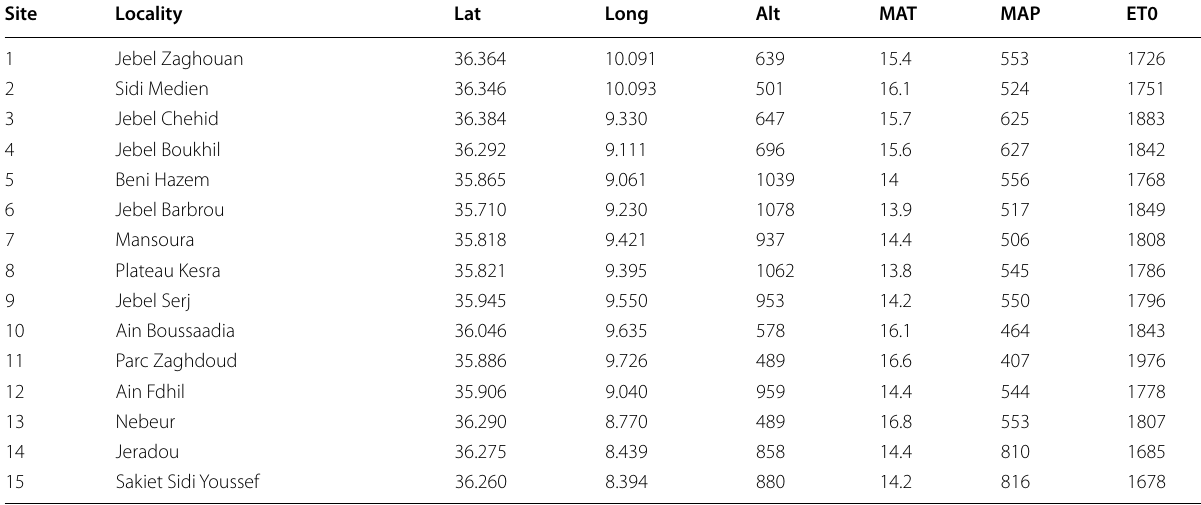
Table 1 Locations of the 15 source populations for Quercus ilex in Northern Tunisia, and their main associated climate characteristics. Lat, latitude (decimal); Long, longitude (decimal); Alt, altitude (m), MAT, mean annual temperature (°C); MAP, mean annual precipitation (mm); ET0, mean annual potential evapotranspiration (mm)